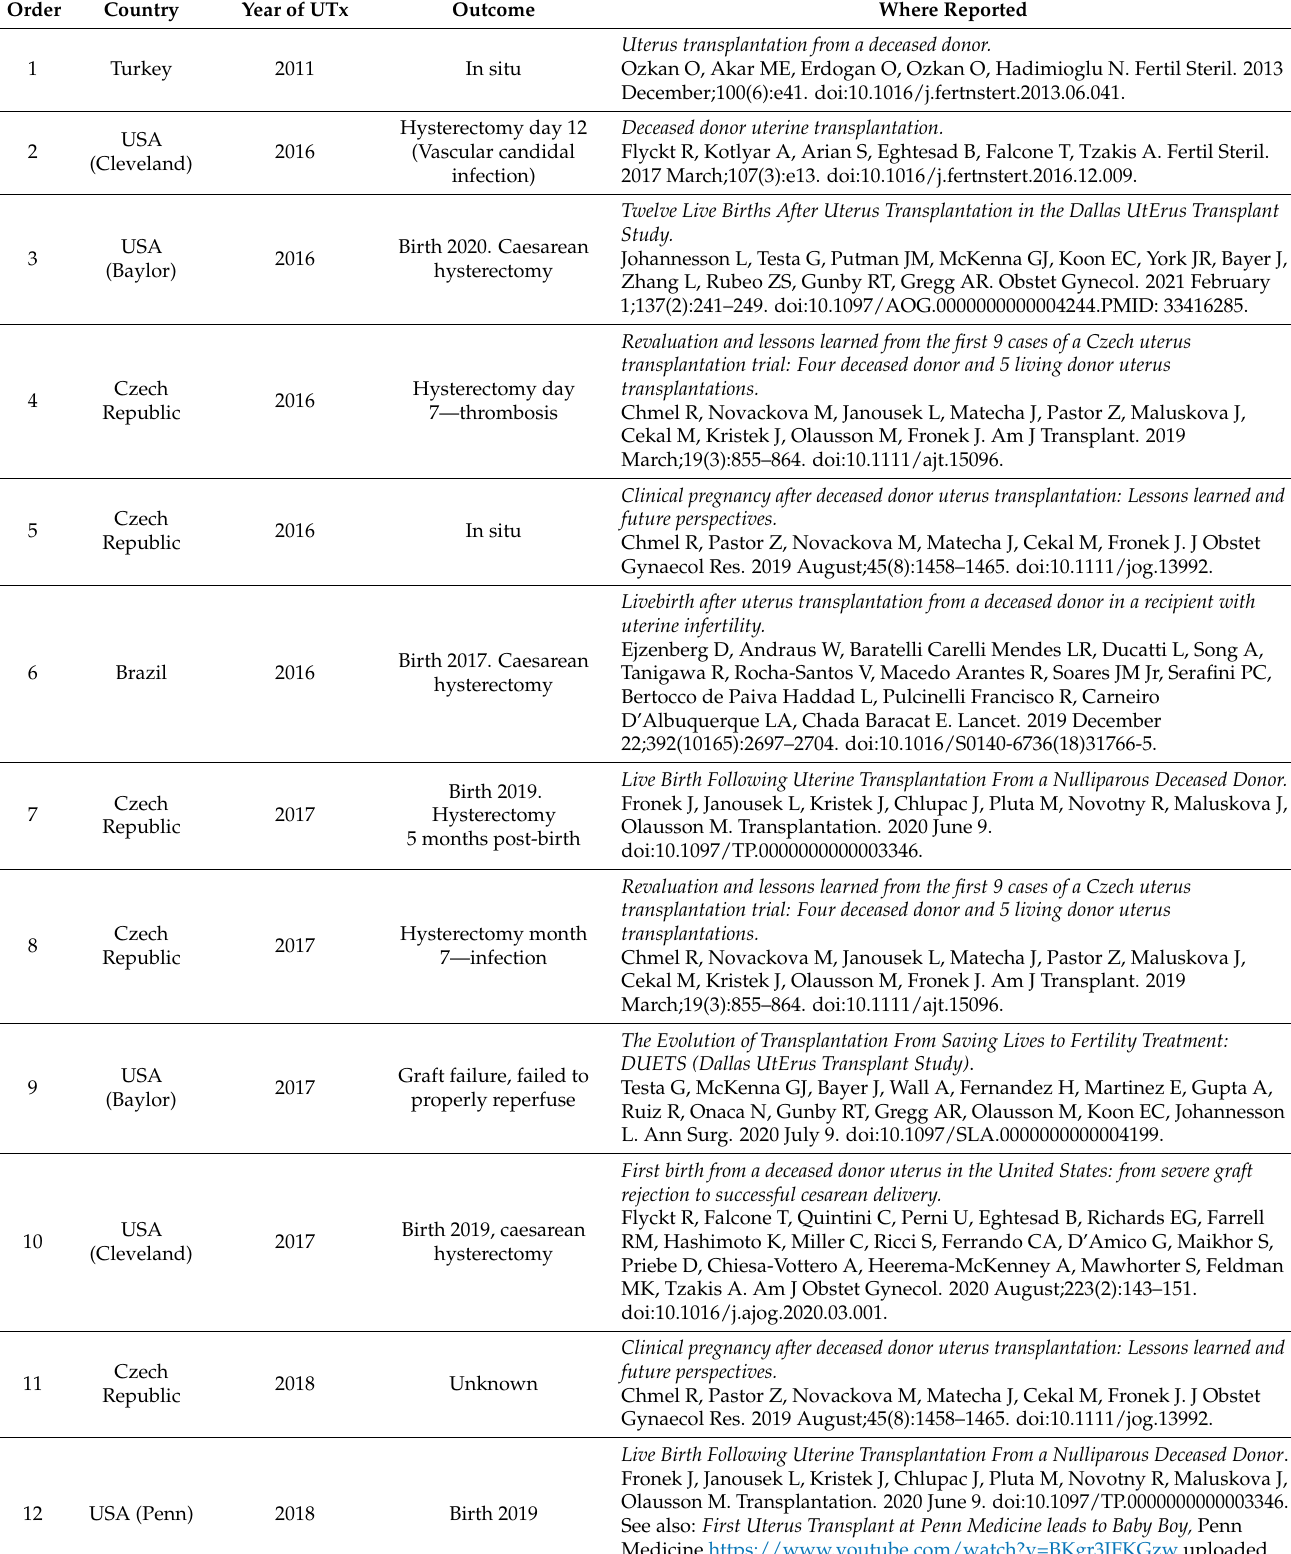
Table 2. Order of deceased donor transplants and outcomes as published in the literature as of 31st January 2021.